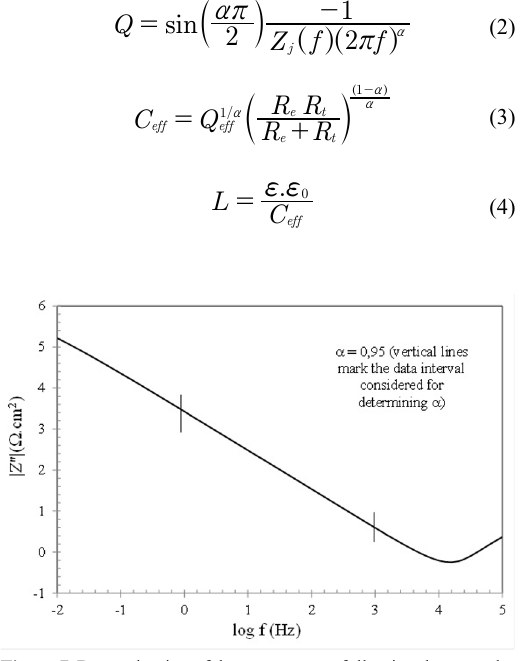
Figure 7. Determination of the α parameter, following the procedure described by Orazem et al. 31